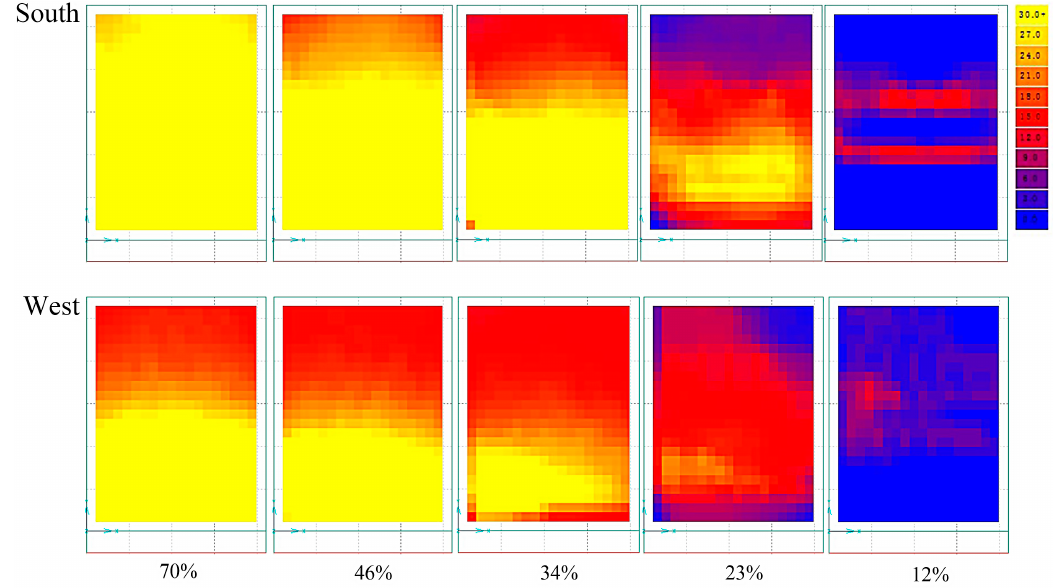
Figure 10. Distribution of over-day lit area in Group 2.